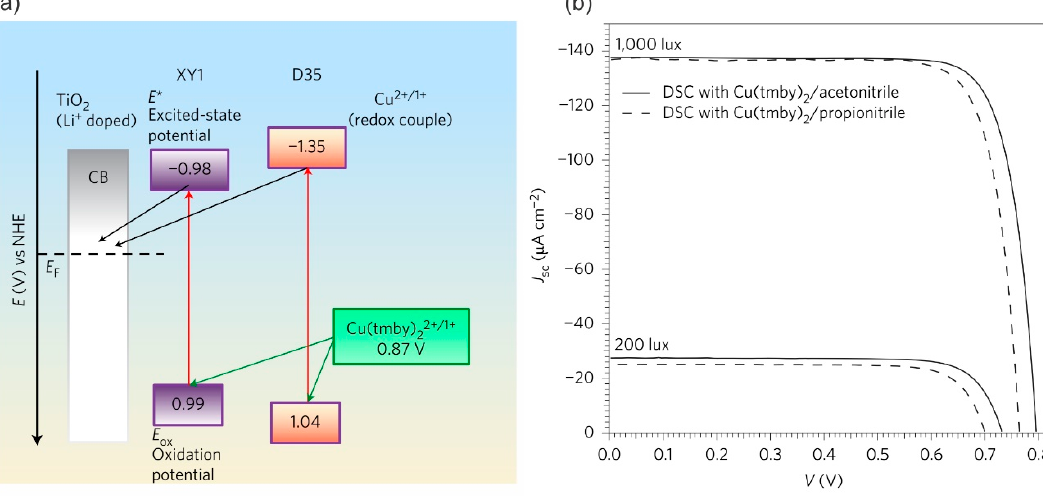
Figure 9. ( a ) Energy level diagram for the XY1 and D35 dyes with the [Cu(tmby) 2 ] 1+/2+ redox couple and ( b ) I–V curve of the co-sensitized DSSC measured under indoor-light conditions. Reprinted with permission from Springer Nature, ref. [19], Copyright (2017).